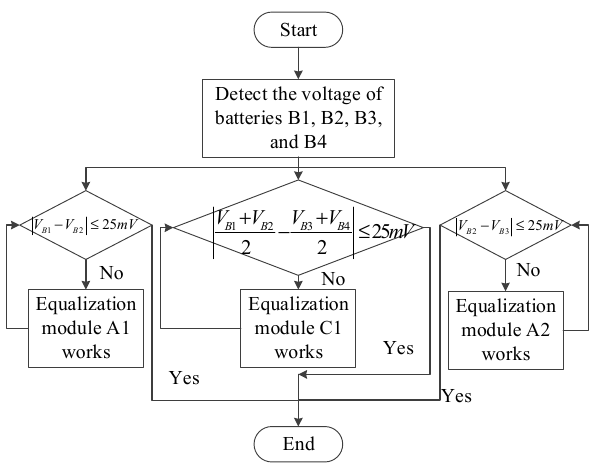
Figure 7. Layered equalization control strategy.